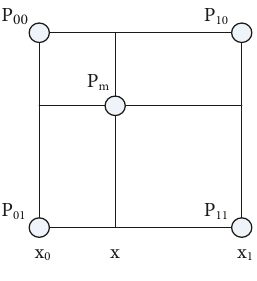
Figure 5: Bilinear